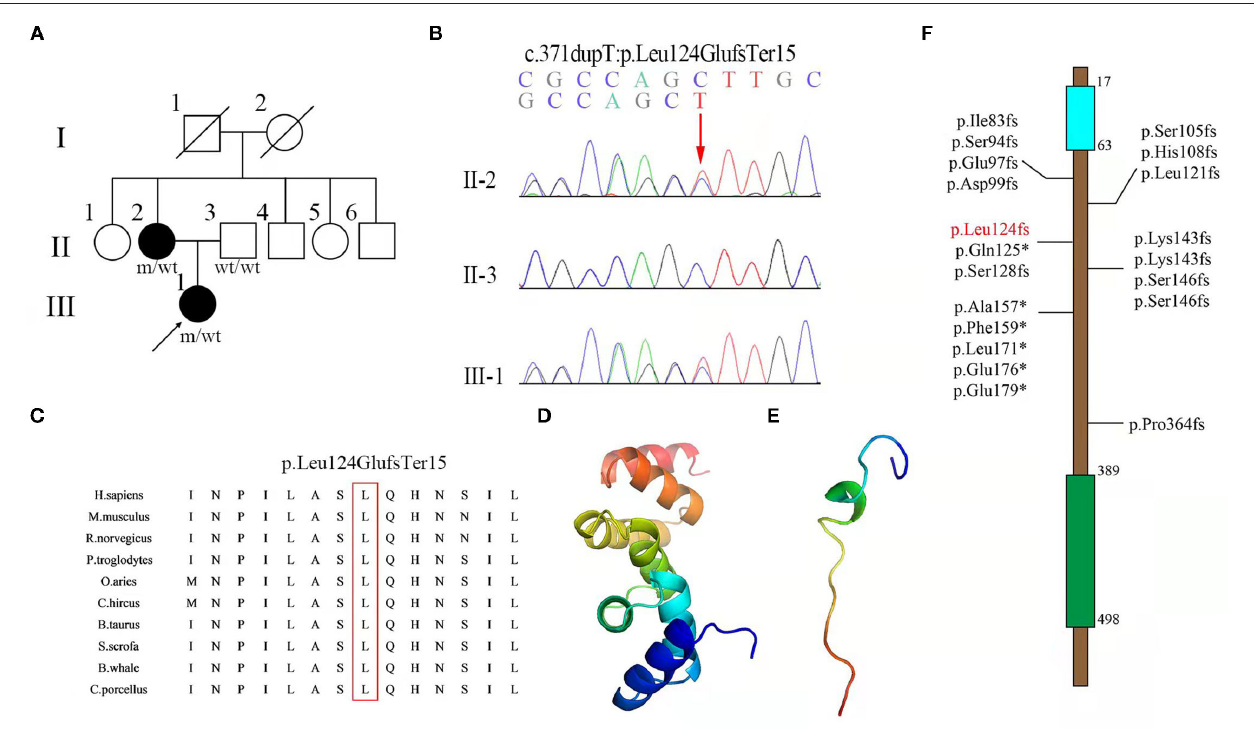
FIGURE 1 | (A) Pedigree of a family with hereditary spastic paraplegia (HSP), with the indicated frameshift mutation of UBAP1 . Squares and circles indicate men and women, respectively. Black symbols represent members with an HSP phenotype, and empty symbols represent unaffected individuals. The arrows indicate patients; wt indicate wide-type; m indicates mutation. (B) Sequence chromatogram showing the c.371dupT variant in UBAP1 in the family. (C) Conservatism analysis of the 124th amino acid among different species. Structures of (D) wild-type and (E) mutant (Leu124GlufsTer15) of the UBAP1 protein were predicted with the Phyre2 web portal. (F) Documented mutations identified in spastic paraplegia-80 (SPG80). The numbers indicate the locations of mutations in protein. Blue and green rectangles indicate the UMA and SOUBA domains, respectively. The mutation found in this study is marked in